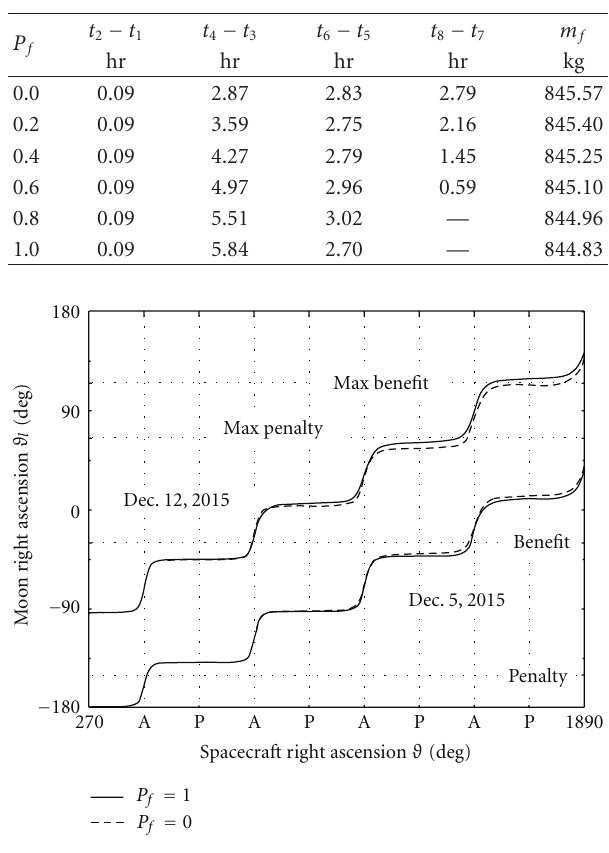
Table 3: Characteristics of the 4.5-revolution transfer with depar- ture on December 1, 2015.